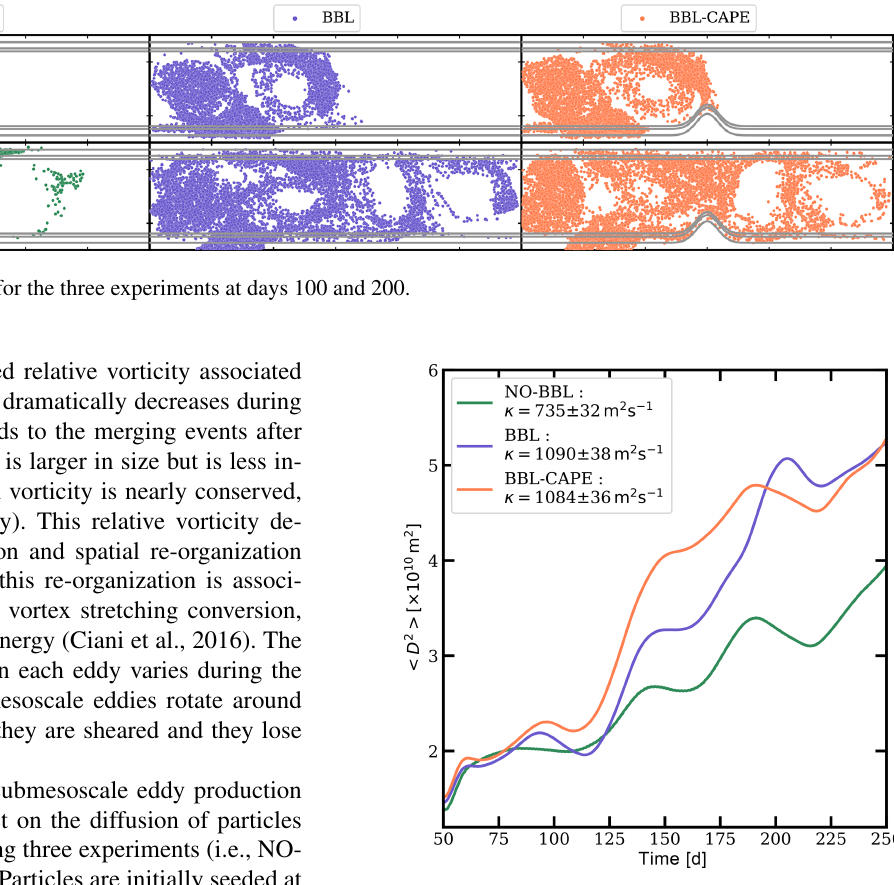
Figure 13. Time evolution of the dispersion < D 2 > computed for the three experiments: (green) NO-BBL, (blue) BBL and (orange)